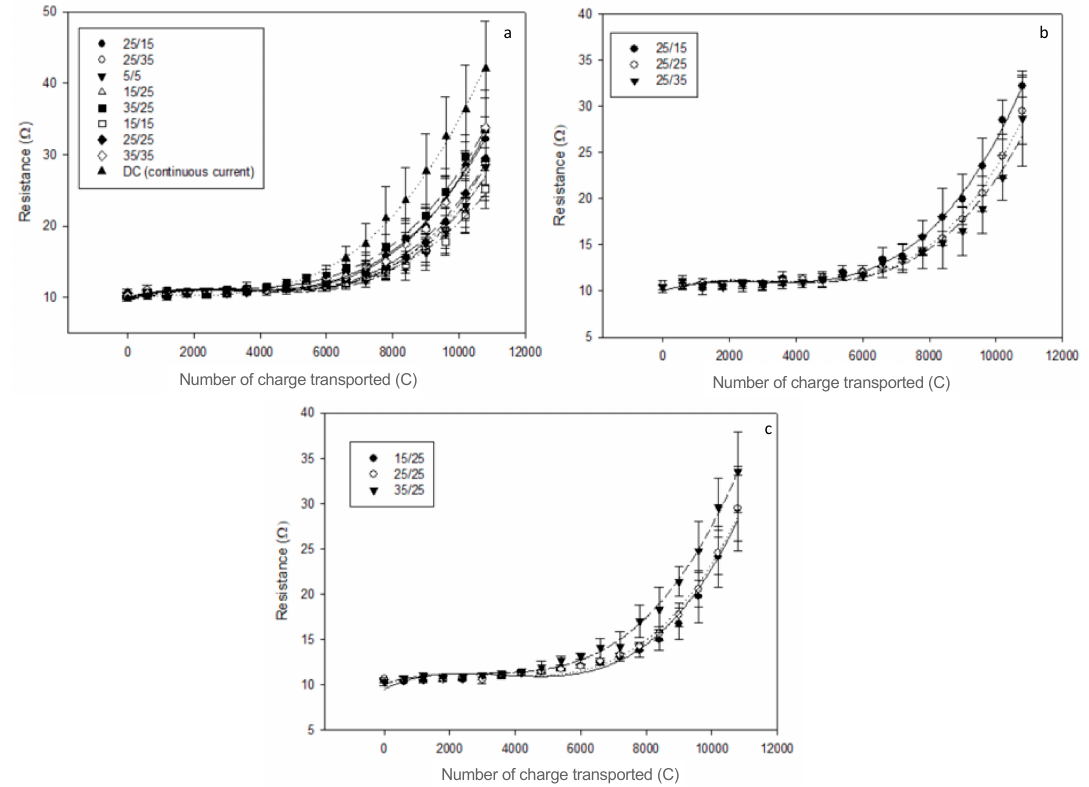
Figure 8. Global system resistance evolution for ( a ) the eight PEF conditions tested plus the application of continuous current from a previous study [13], ( b ) the three PEF conditions involving pause duration variations, and ( c ) the three involving pulse duration variations. Table 2. Relative energy consumption for the eight PEF conditions after 3 hours of e ff ective current application during the ED treatment of acid